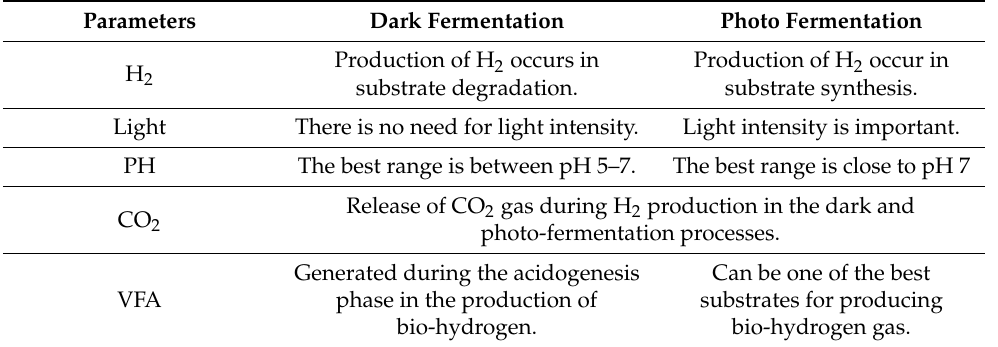
Table 2. Contrast between dark fermentation and photo fermentation processes.